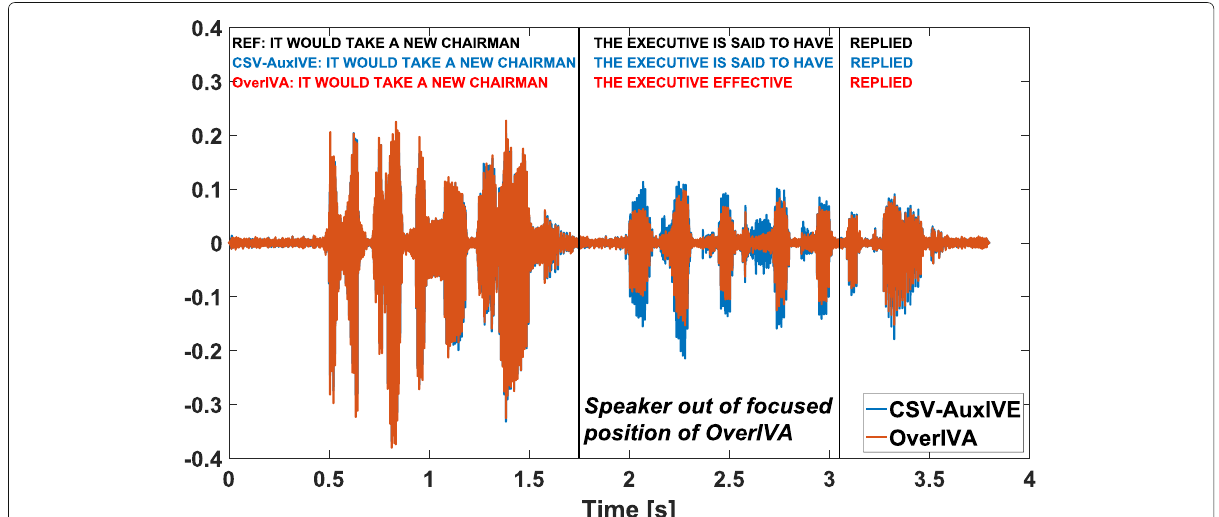
Fig. 7 Comparison of enhanced signals yielded from a recording of a moving speaker by OverIVA and CSV-AuxIVE